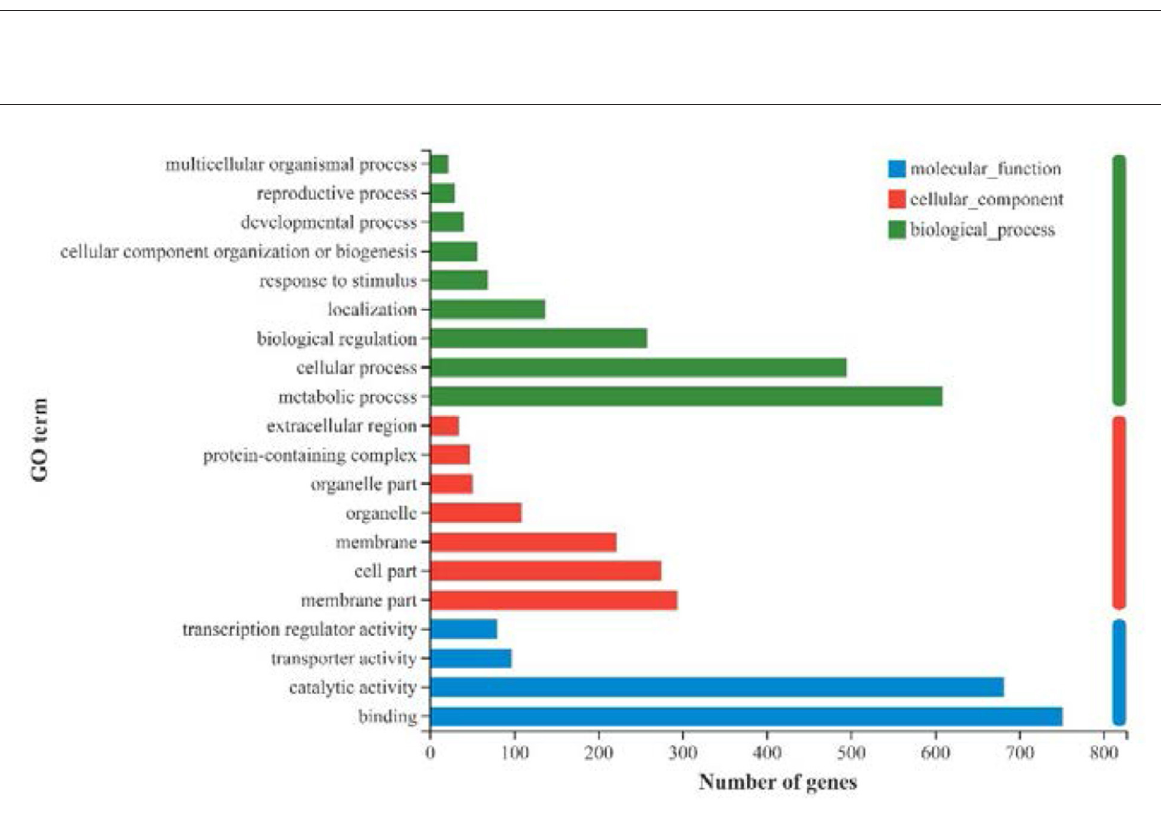
FIGURE6 GO annotation of all DEGs (|log2FC| > 1, p -adjust < 0.05) in strawberry fruit after ultrasound